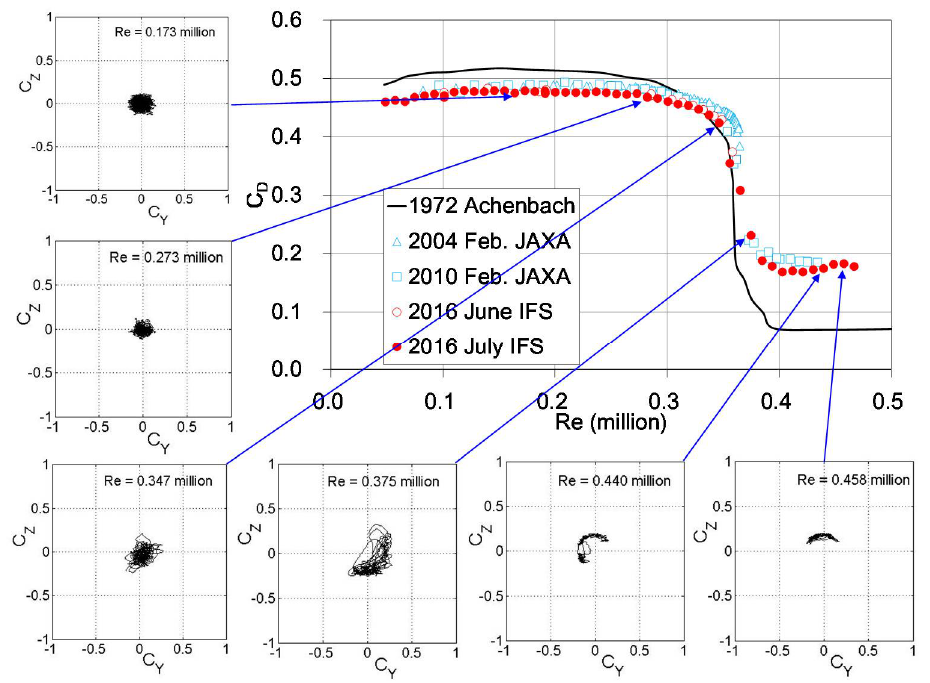
Figure 6. Drag coefficient vs Reynolds number and lateral force coefficient as seen from behind the